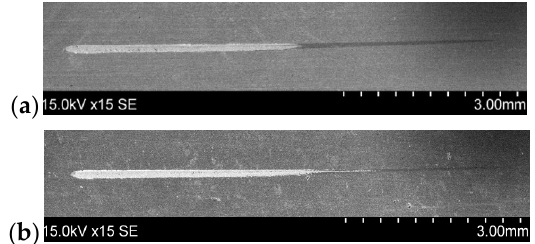
Figure 6. Scratch test results for PVD coatings (×15): ( a ) CrN coating; ( b ) TiAlN coating.